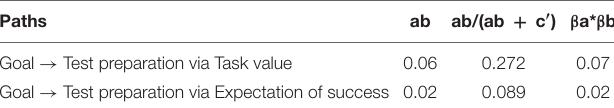
TABLE 4 | Measurement of mediating